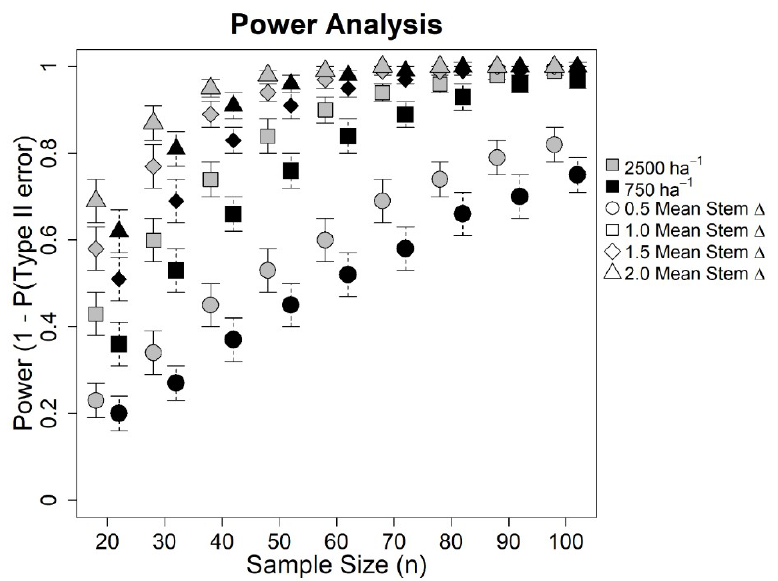
Figure 5. Statistical power to detect mean tree seedling stem change across sample size (20 to 100) and scale (1/2500th ha and 1/750th ha) based on simulated tree seedling stem counts with added sampling (observer error). Shapes indicate different levels of mean tree seedling stem change added to initial plot stem counts (circle = 0.5, square = 1.0, diamond = 1.5, and triangle = 2.0), while color indicates scale (gray = 1/2500th ha, and black = 1/750th ha). Dashed black lines and solid gray lines represent the standard deviation of each point estimate for the 1/2500th and 1/750th ha, respectively.